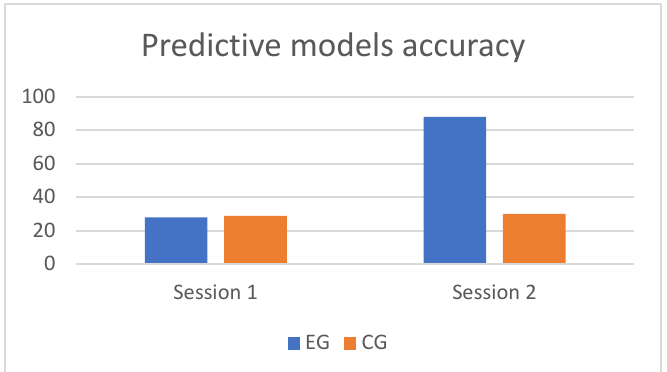
Figure 3. Correctly Classified Instances percentages (C.C.I.%) of classification models obtained by training with the arousal and valence values for NM1 session 1 and NM1 post session 4. Average arousal and valence values were computed for each type of emotion stimuli in condition NM in session one and in session four. Figure 4 shows normalized averages plotted in the arousal (y-axis) valence (x-axis) plane.